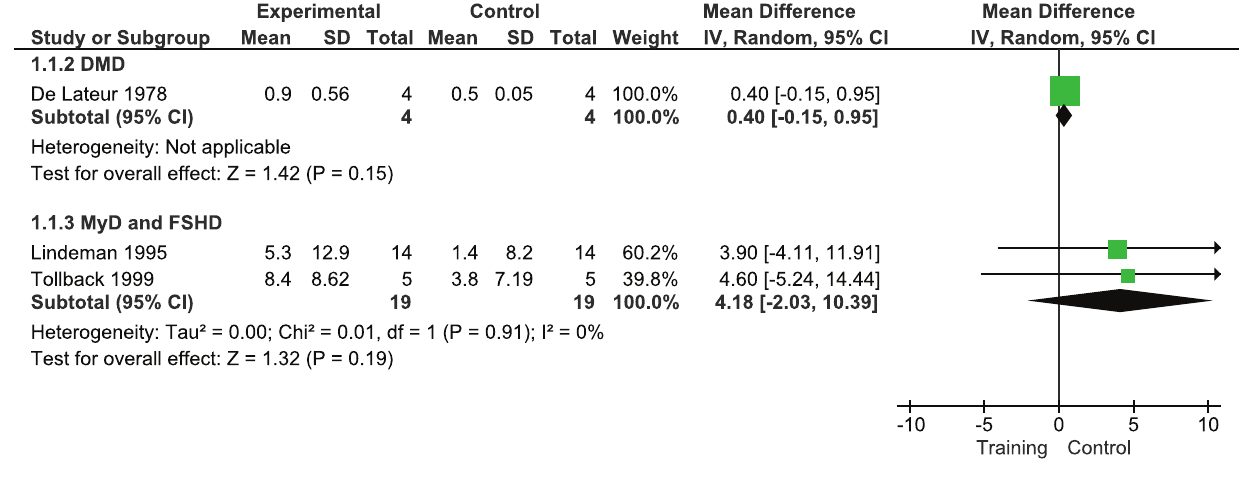
Figure 4. Effect of muscular exercise on strength as MVIC knee extension.